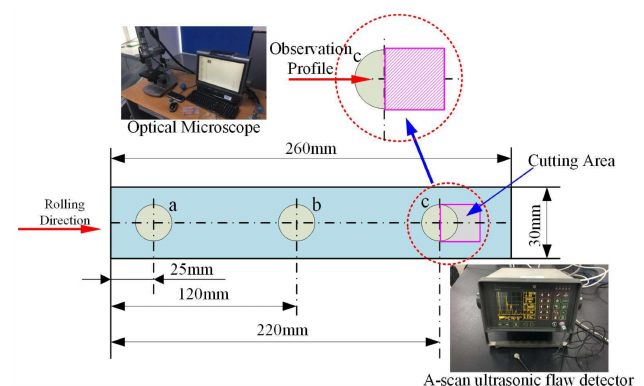
Figure 6. Offline detection method.